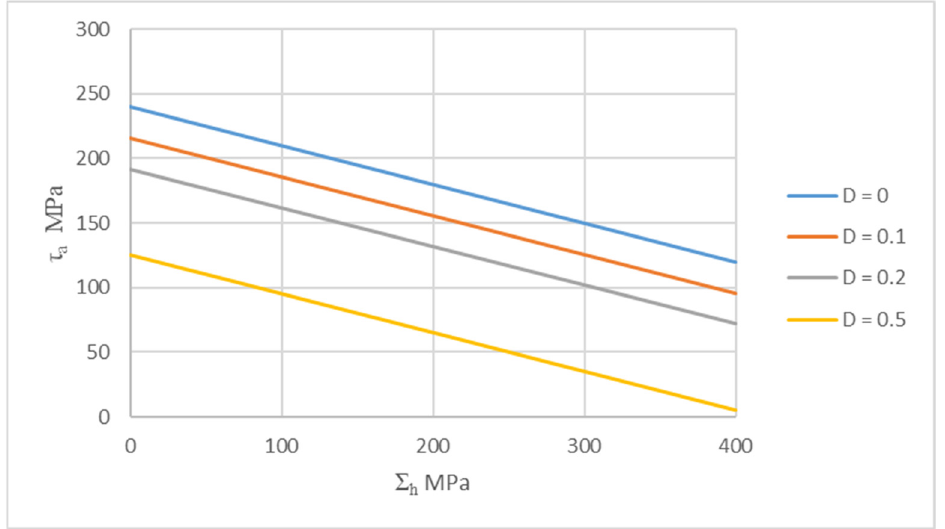
Figure 9. Dang Van multiaxial fatigue diagram (Shear stress versus Hydrostatic stress) for different damage levels.